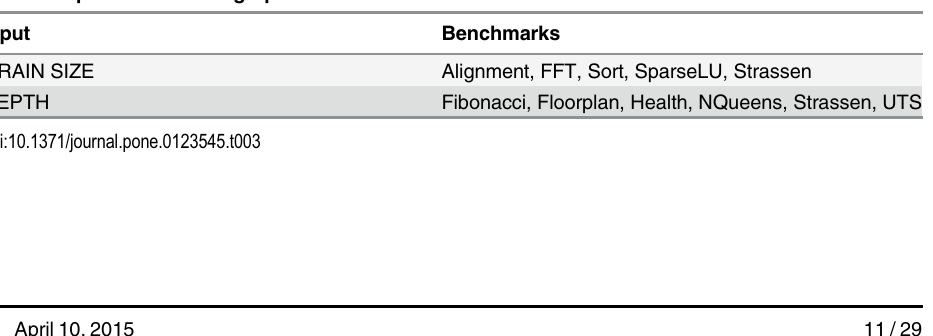
Table 3. Inputs to limit task graph size in BOTS